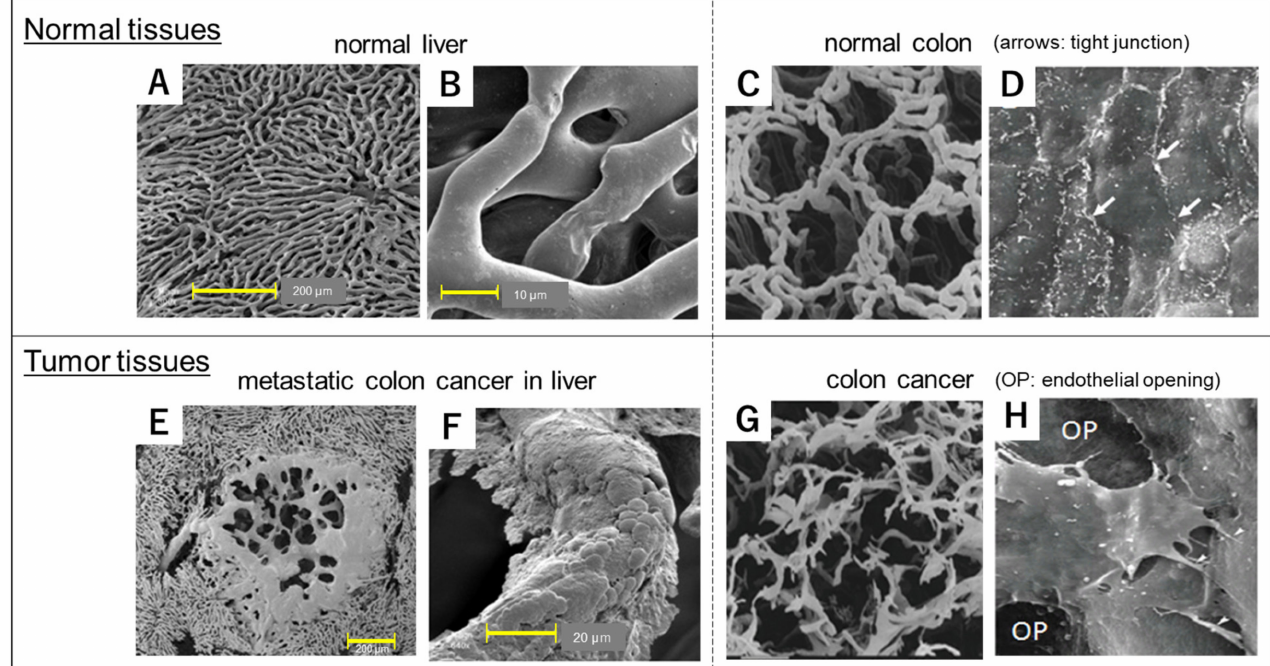
Figure 1. Comparison of scanning electron microscopy (SEM) images of blood vessels in normal, healthy tissues ( A – D ) and tumor tissues ( E – H ). Blood vessels in healthy tissue in ( A – C ) show clear, smooth, regular features and no leakage of polymeric resin. In contrast, the tumor vessels show leakage of polymeric resin at the capillary level ( E ). Although normal colonic tissue consists of organized vascular casts ( C ), colon tumor tissue shows a disorganized, irregular vascular network ( G ). The luminal surface of normal blood vessels ( D ) shows tight cell-cell junctions in the endothelium whereas blood vessels in the tumor ( H ) have large gaps (OP in H ) among the endothelial cells. Adapted from reference [14]